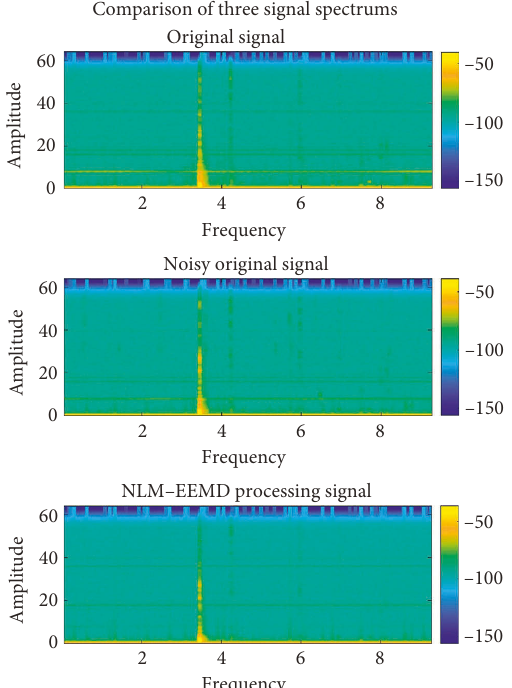
Figure 20: Spectrum of experimental signal.